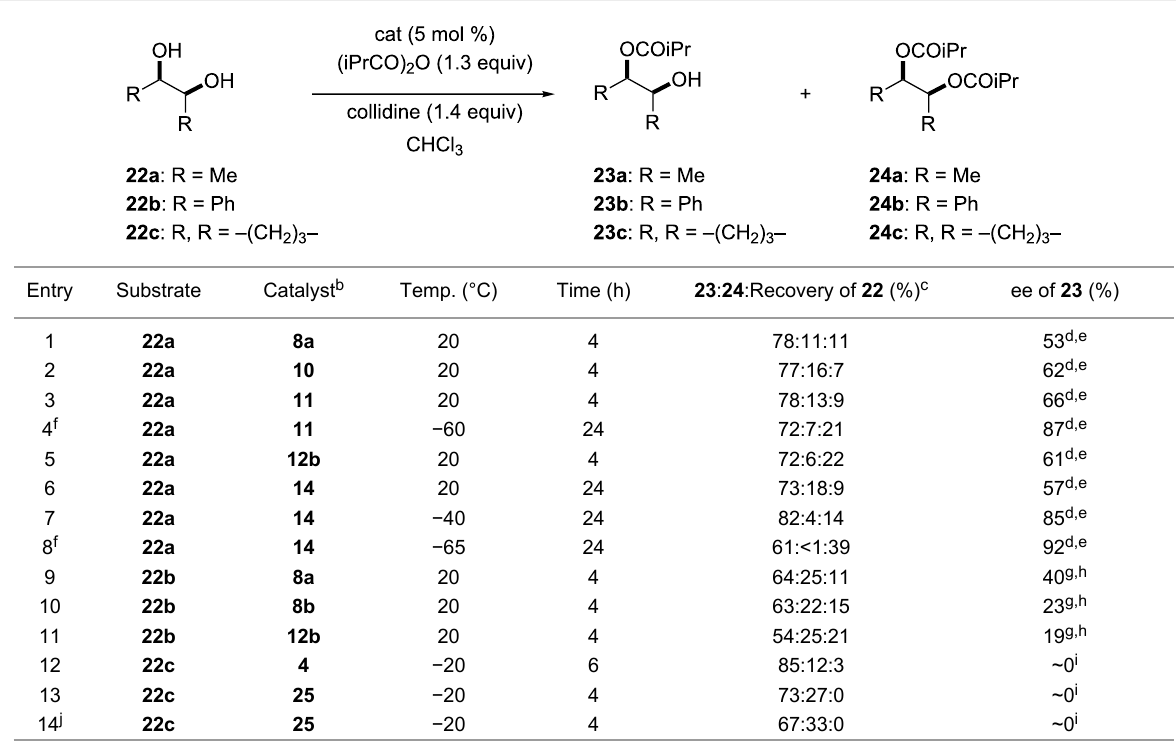
Table 6: The asymmetric desymmetrization of meso -2,3-butanediol ( 22a ), meso -hydrobenzoin ( 22b ) and meso -1,2-cyclopentanediol ( 22c ). a